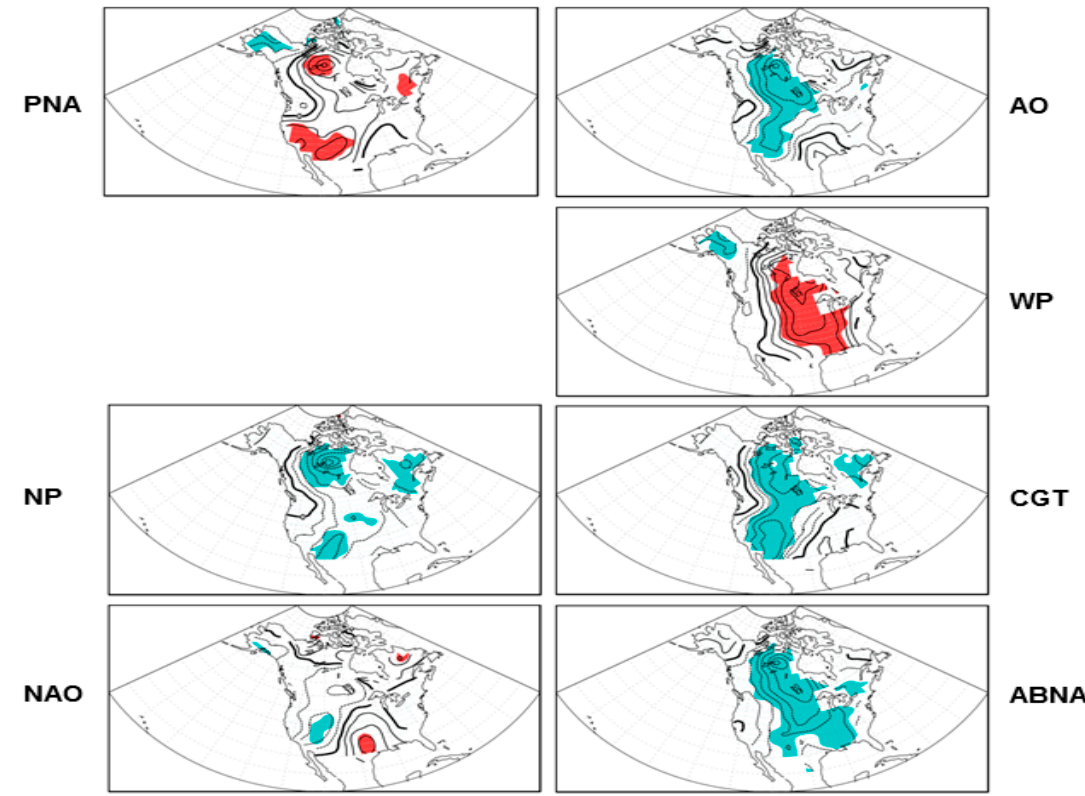
Figure 9. As in Figure 3, but for the JJA mean TN10p anomalies with contour interval 0.5%.